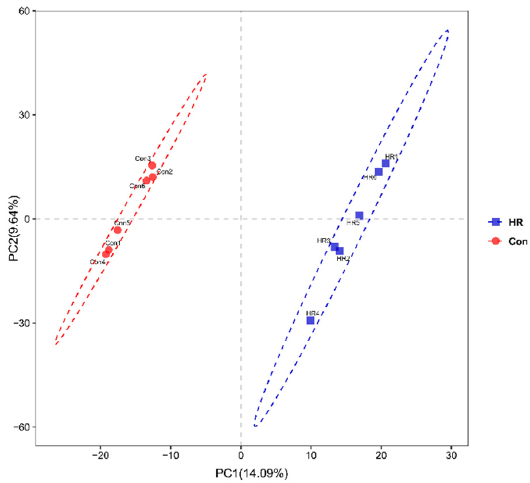
Figure 3. Principal component analysis (PCA) of the colonic bacterial community.